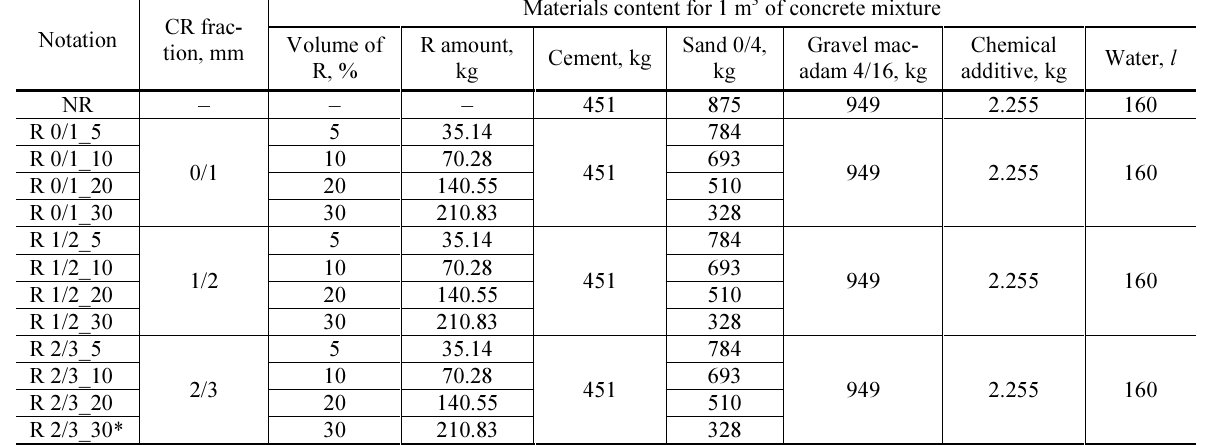
Table 1. Compositions of concrete mixtures